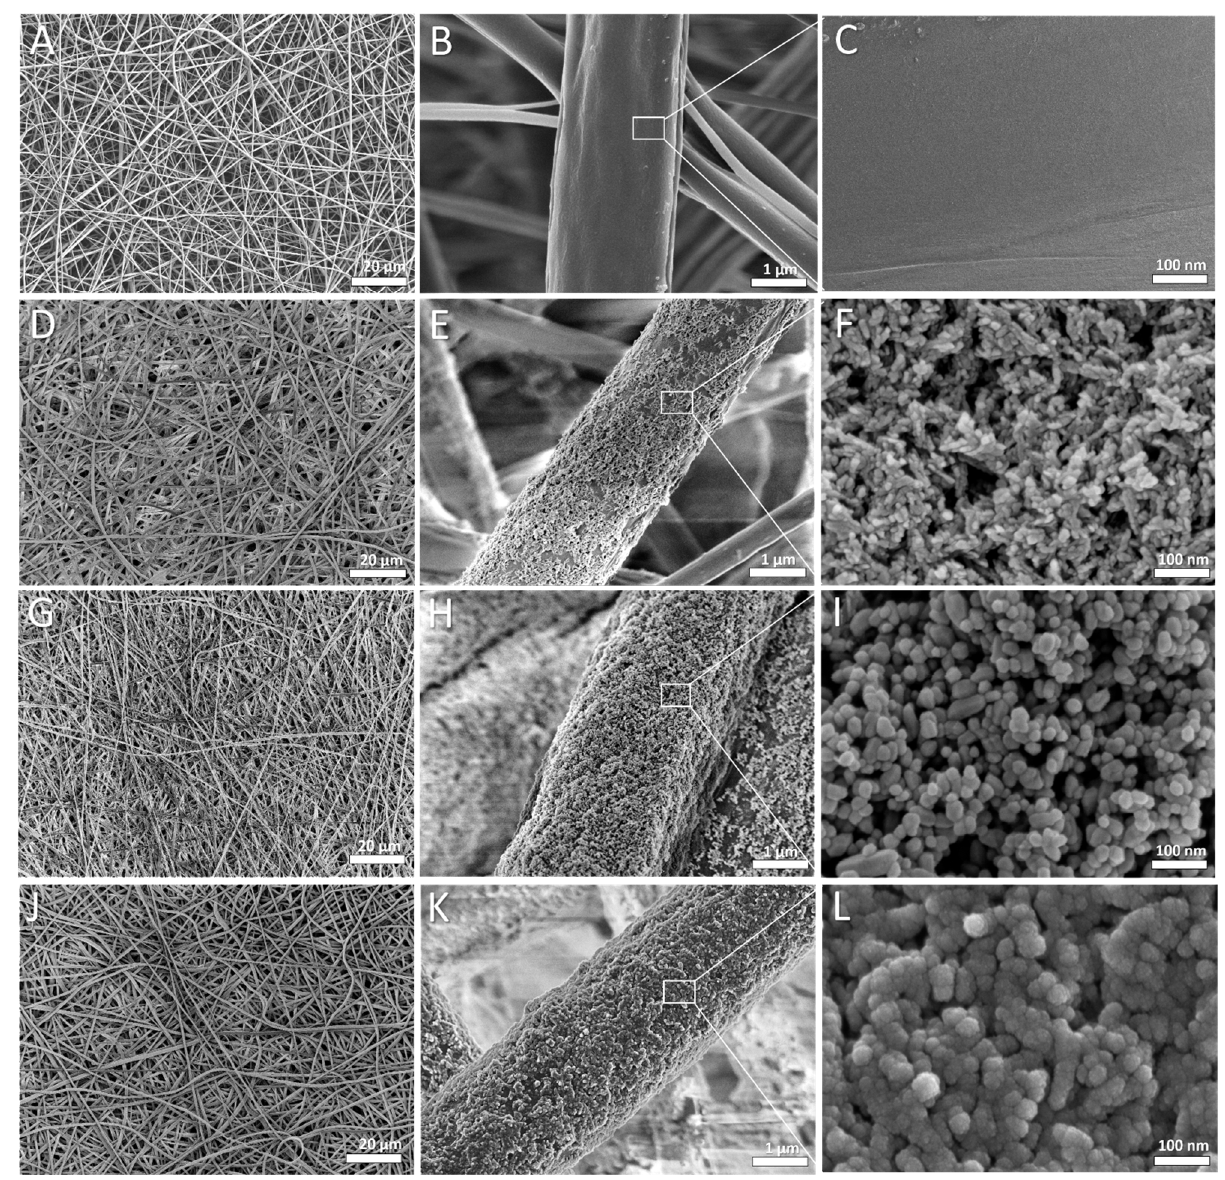
Figure 4. SEM images of obtained fibers: PDLLA/PLGA ( A – C ), PDLLA/PLGA/nHA ( D – F ), PDLLA/PLGA/nZnO:Ag ( G – I ), and PDLLA/PLGA/nHA/nZnO:Ag ( J – L ).